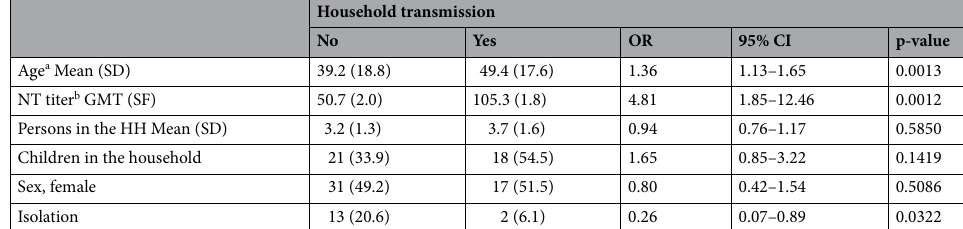
Table 6. Predictors of risk of household transmission by attributes of the index case and household. CI confidence interval, GMT geometric mean titer, NT neutralization test, SF Scatter factor, SD standard deviation. a Odds ratio (OR) by 10 years increase. b OR by tenfold